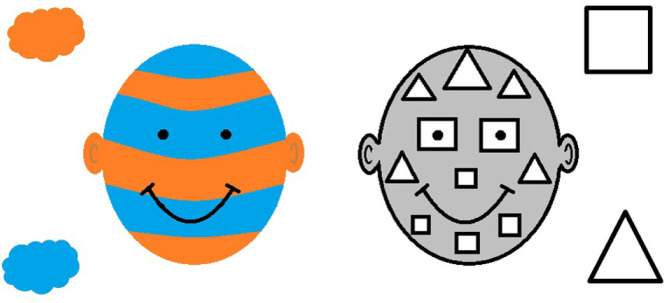
Introduction of cues on the nonverbal switching task.